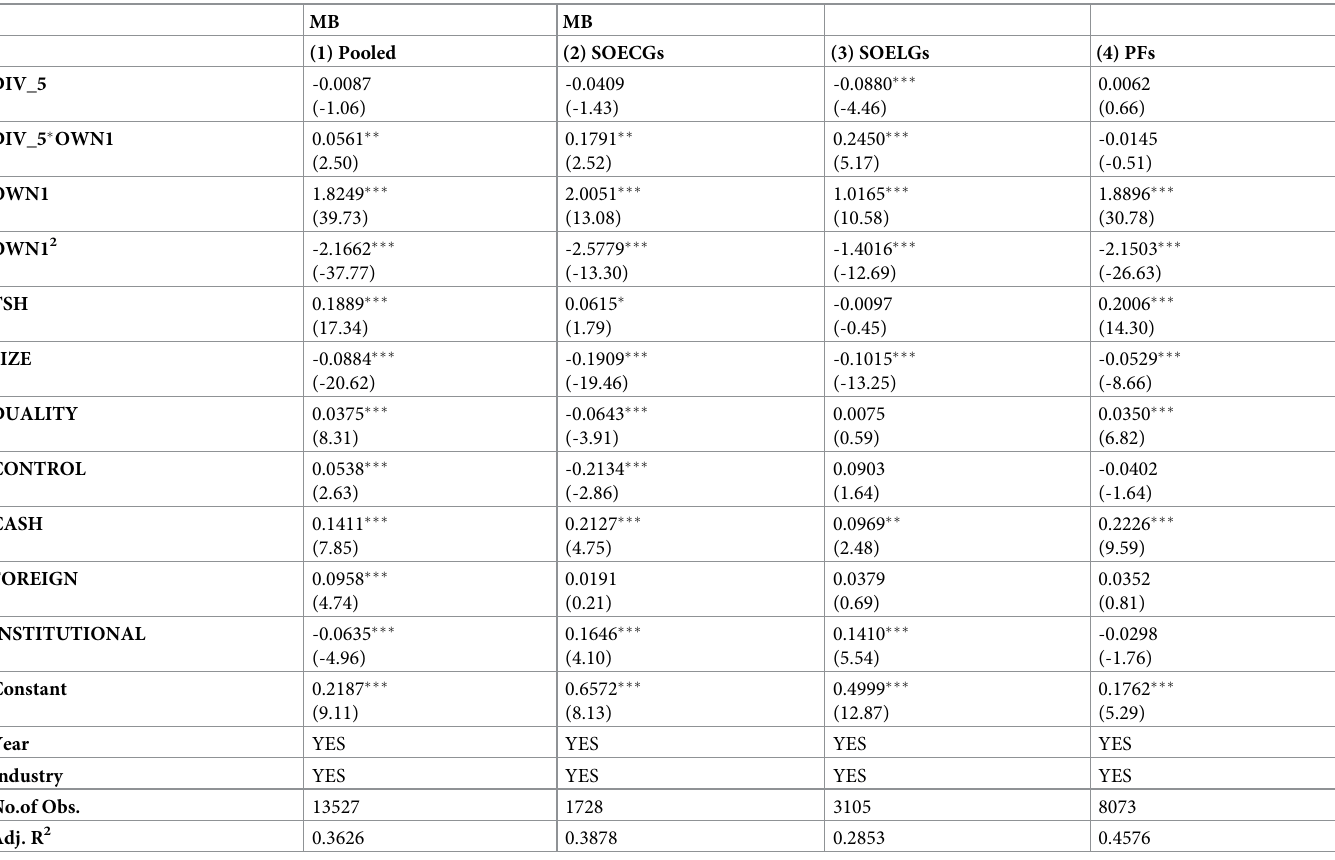
Table 4. Effect of continuous cash dividends on the relation between ownership concentration and firm